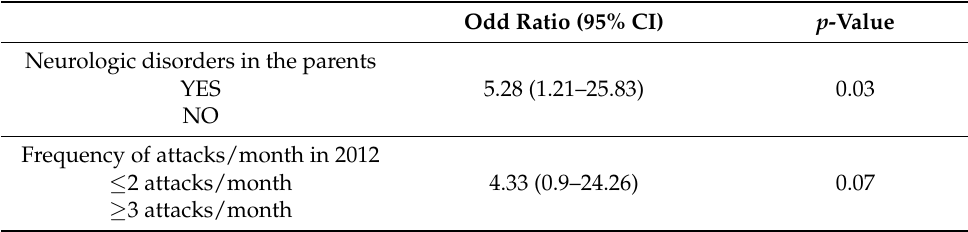
Table 4. Multivariable logistic regression models of the long-term prognostic